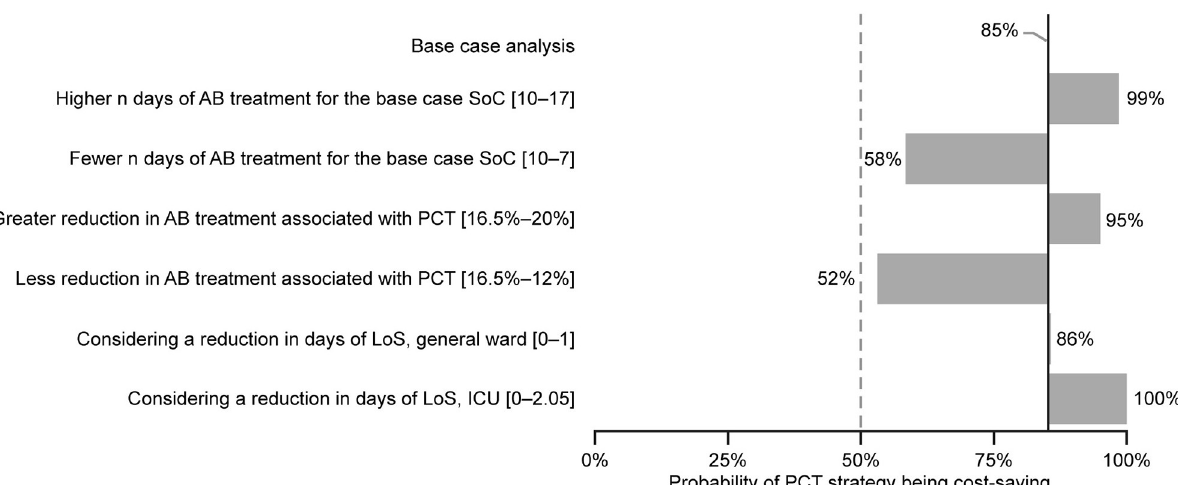
PLOS ONE | https://doi.org/10.1371/journal.pone.0250711 April 30,